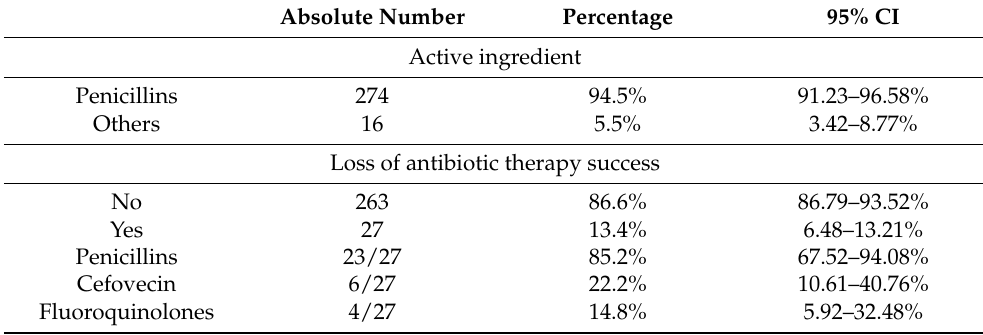
Table 6. Bite wounds. Number, percentages, and 95% CI of responses regarding bite wounds according to the frequency of the used active ingredients and the antibiotic groups for which a loss of therapeutic success was observed. A total of 290 questionnaires from a survey among German veterinarians were analyzed for this